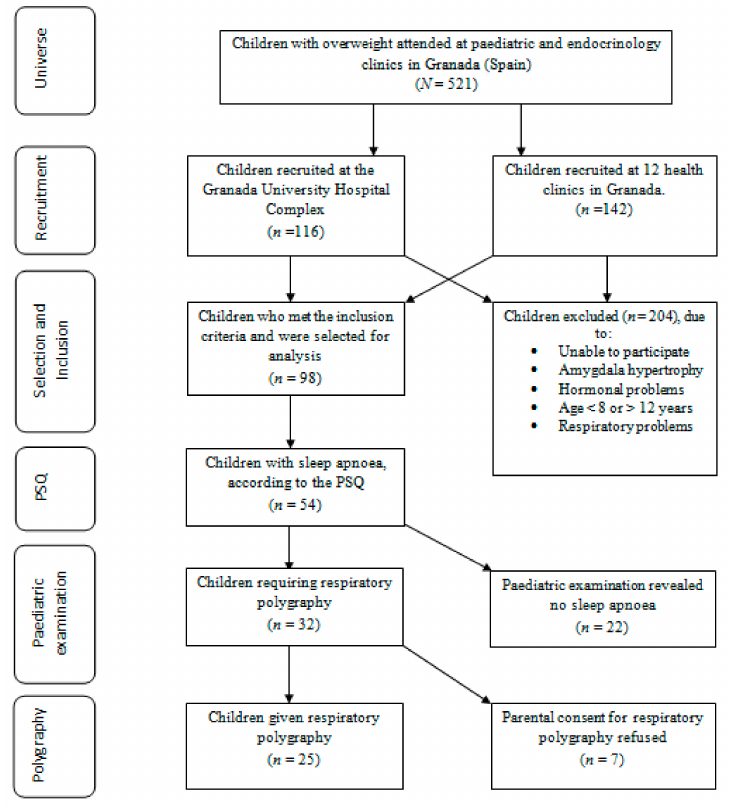
Figure 1. Sample selection.